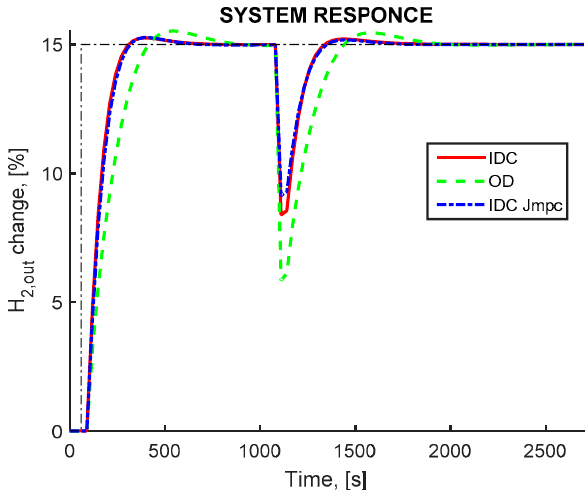
Figure 8. Pure hydrogen production rate (controlled variable). CRMRM flowsheet, IDC( J COST ) framework (red continuous line) OD framework (green dashed line) IDC( J MPC ) framework (blue dashed-dot line). Setpoint change for hydrogen production at 150 s and disturbance influence at 1000 s.